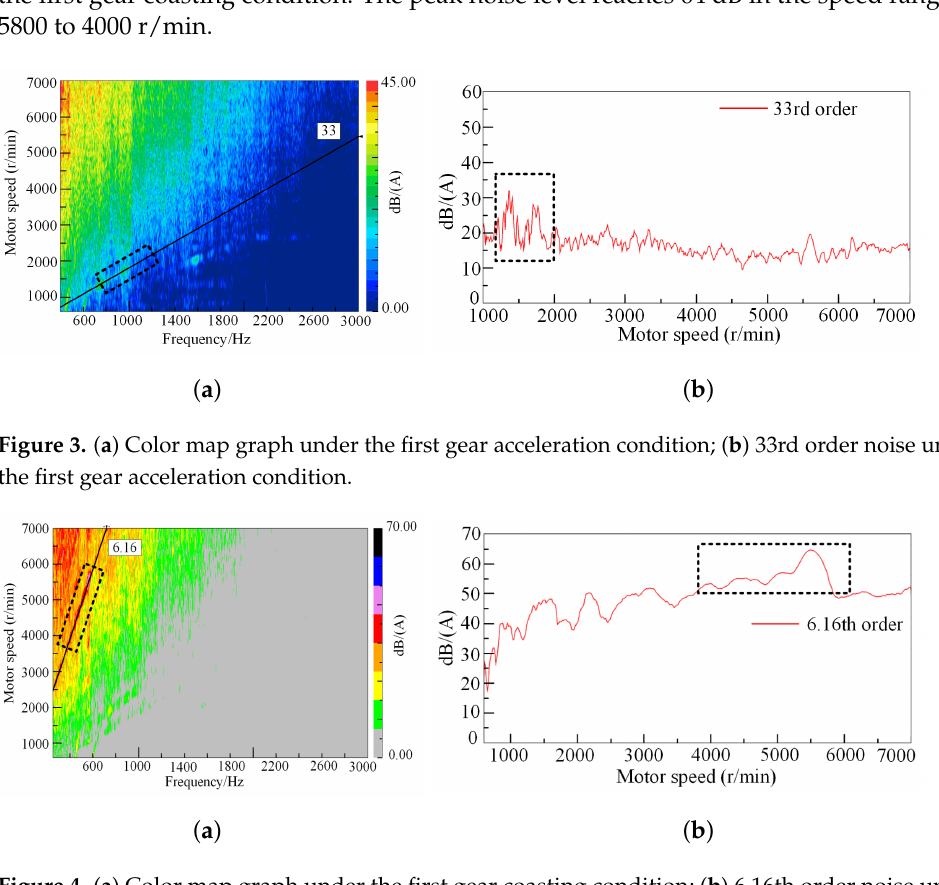
Figure 4. ( a ) Color map graph under the first gear coasting condition; ( b ) 6.16th order noise under the first gear coasting condition.